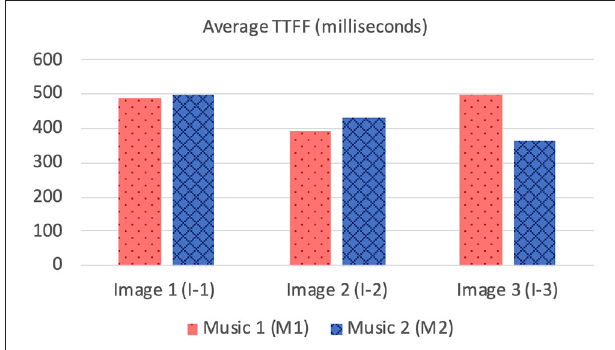
FIGURE 2 | Average time to first